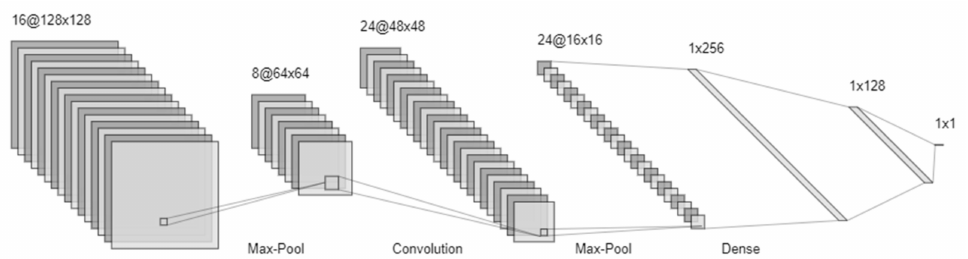
Figure 7. Visualization of convolutional neural network architecture specifically designed for clas- sification based on image data. A series of 16@128 × 128 images are input to the network. These frames are passed through a max pooling layer and a convolutional layer before being flattened into a 1D vector. Two fully connected layers of size 256 and 128 connect to a final node containing the network